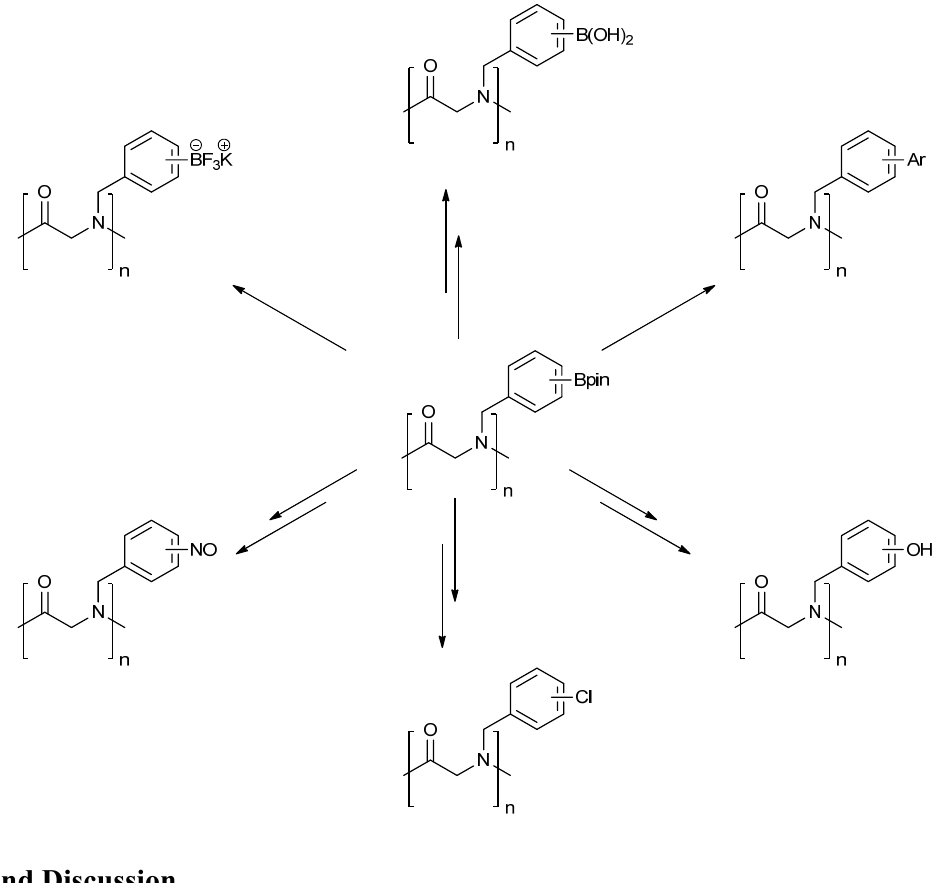
Figure 2. Functional group transformations from boronate